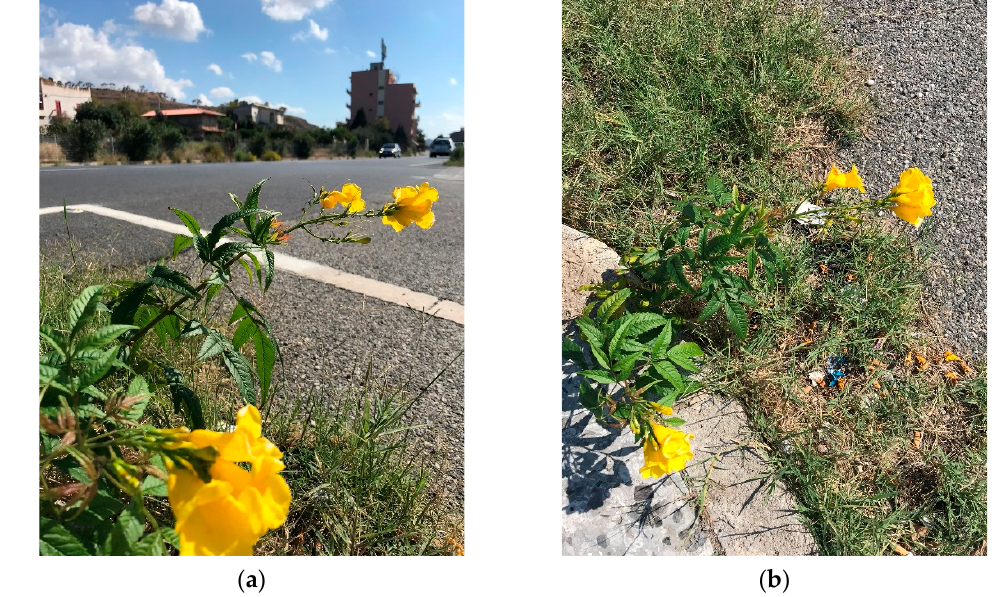
Figure A10. The individual of Tecoma stans (L.) Juss. ex Kunth collected in Bocale (Reggio Calabria